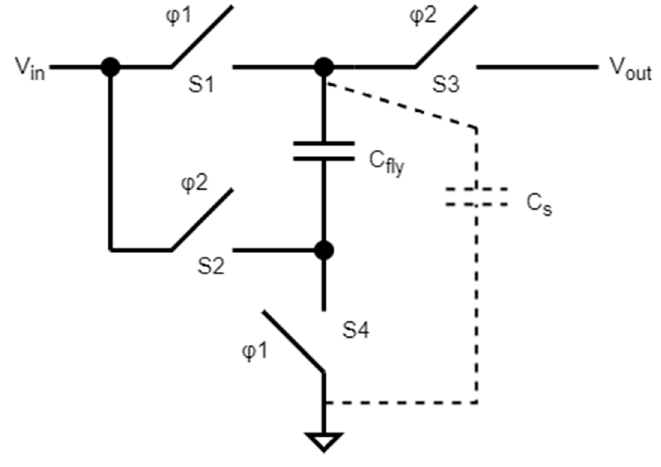
Figure 1. Charge pump